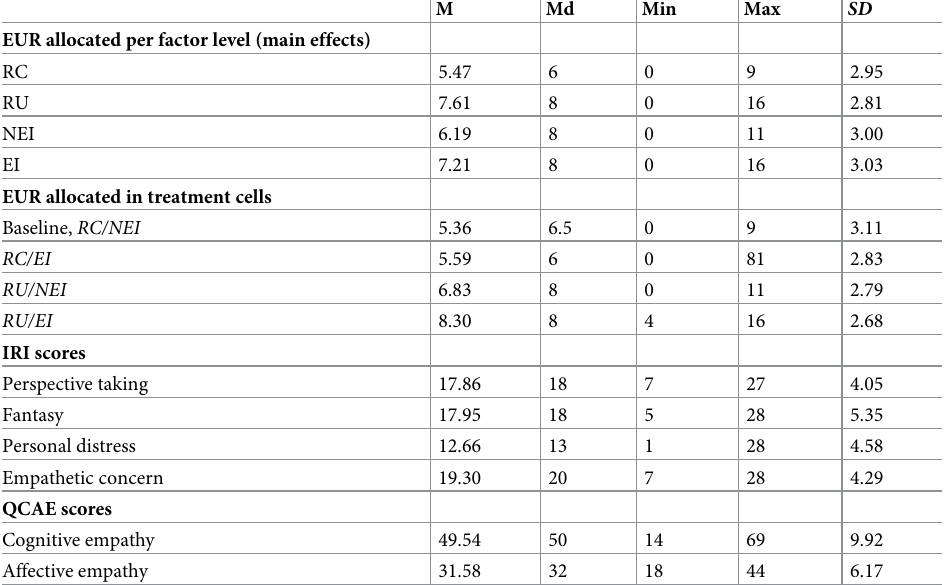
Table 2. Descriptive statistics of employed